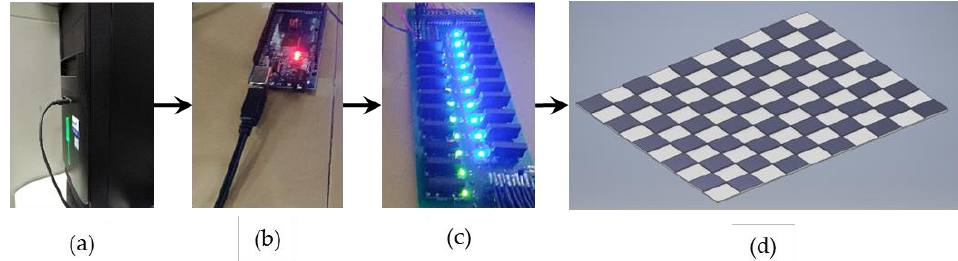
Figure 7. ( a ) PC that serially communicates with Arduino; ( b ) Arduino Mega Microcontroller; ( c ) Custom PCBA interfacing the Switchable Glass; ( d ) 3D CAD design of the Switchable Glass.